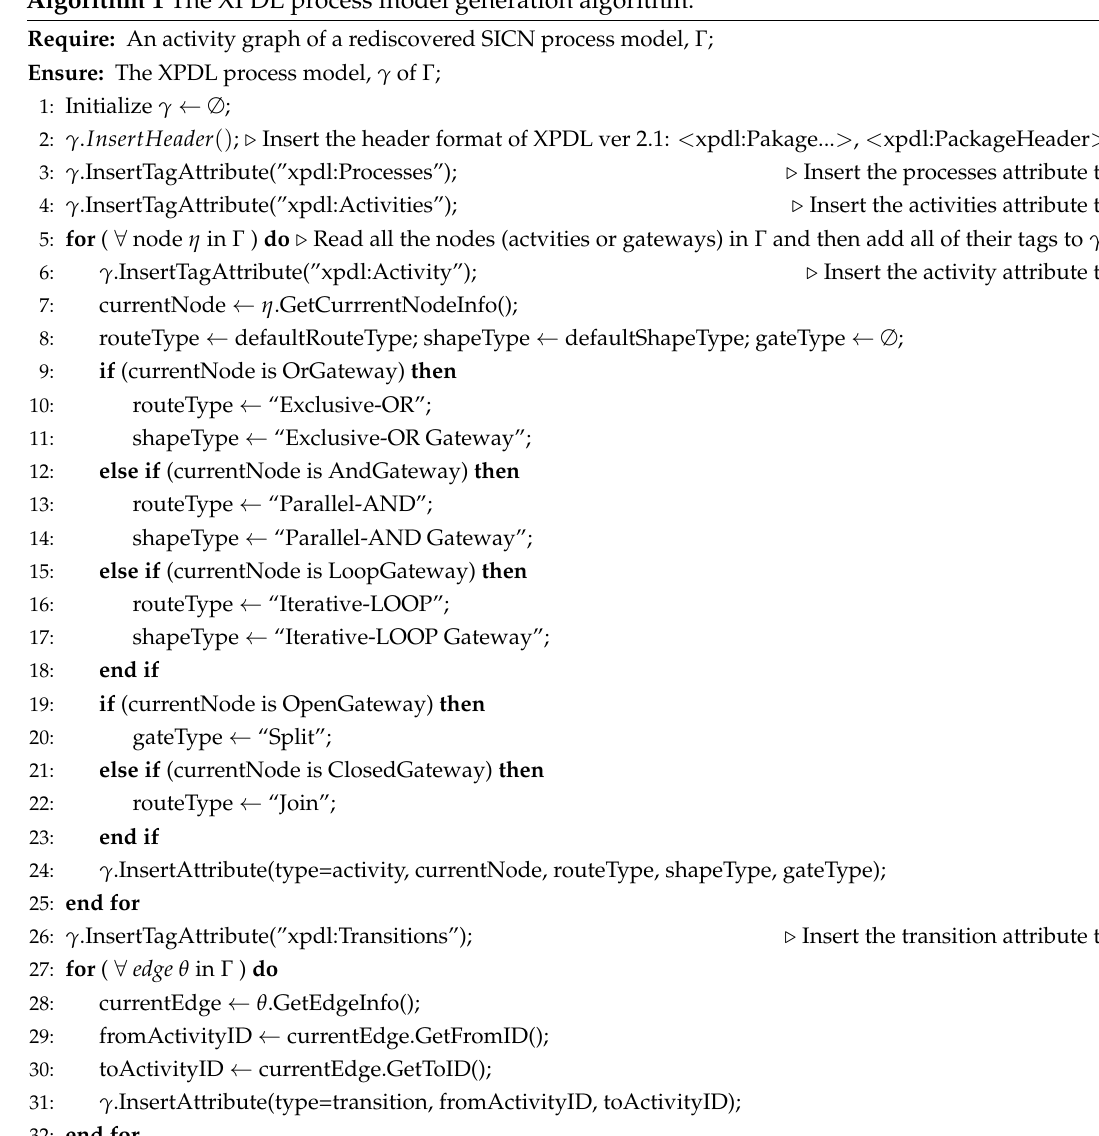
Algorithm 1 The XPDL process model generation